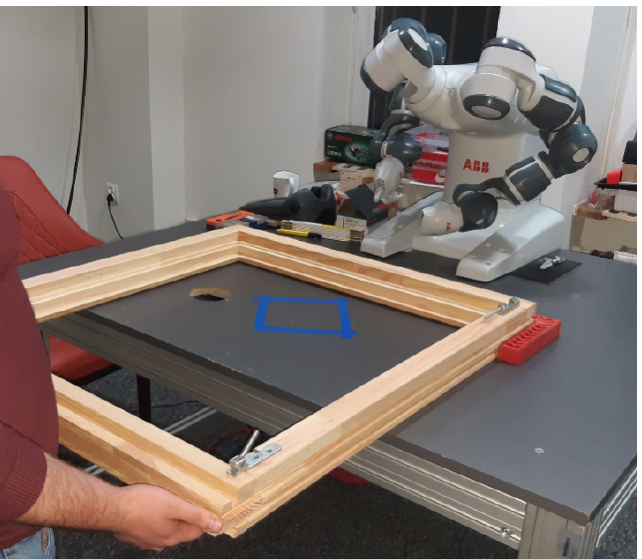
Figure 4. The co-bot interactive helper workbench. The interaction interface hardware is the same as presented in the next